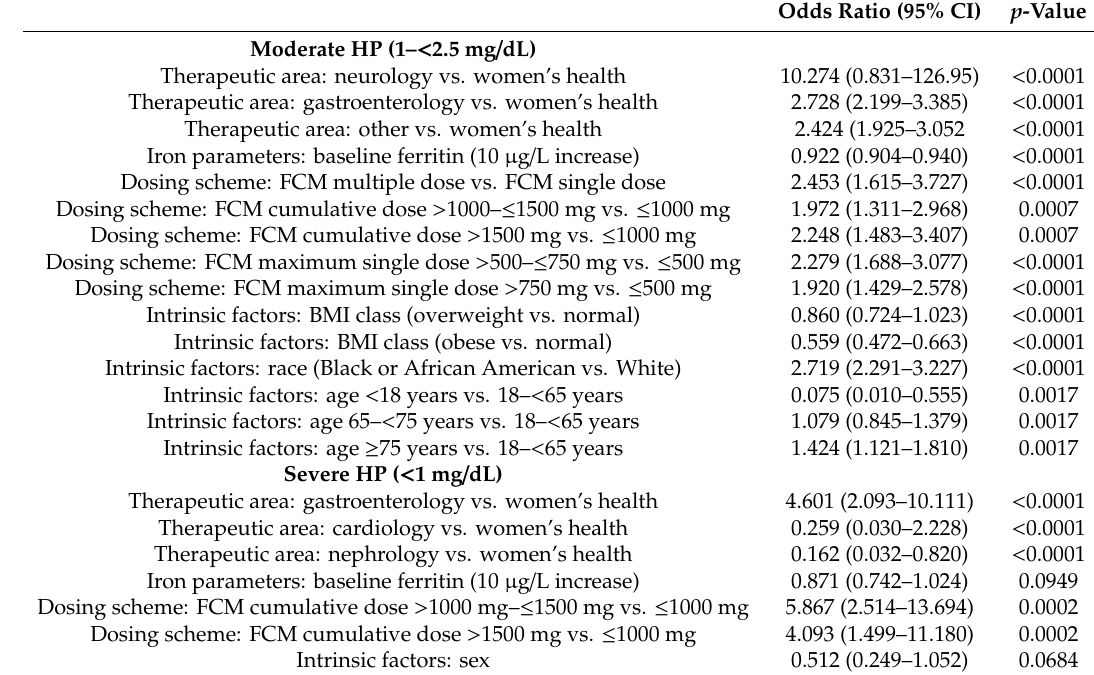
Risk factors for developing moderate and for developing severe post-baseline hypophosphataemia as determined by logistic regression analyses. Analysis restricted to subjects